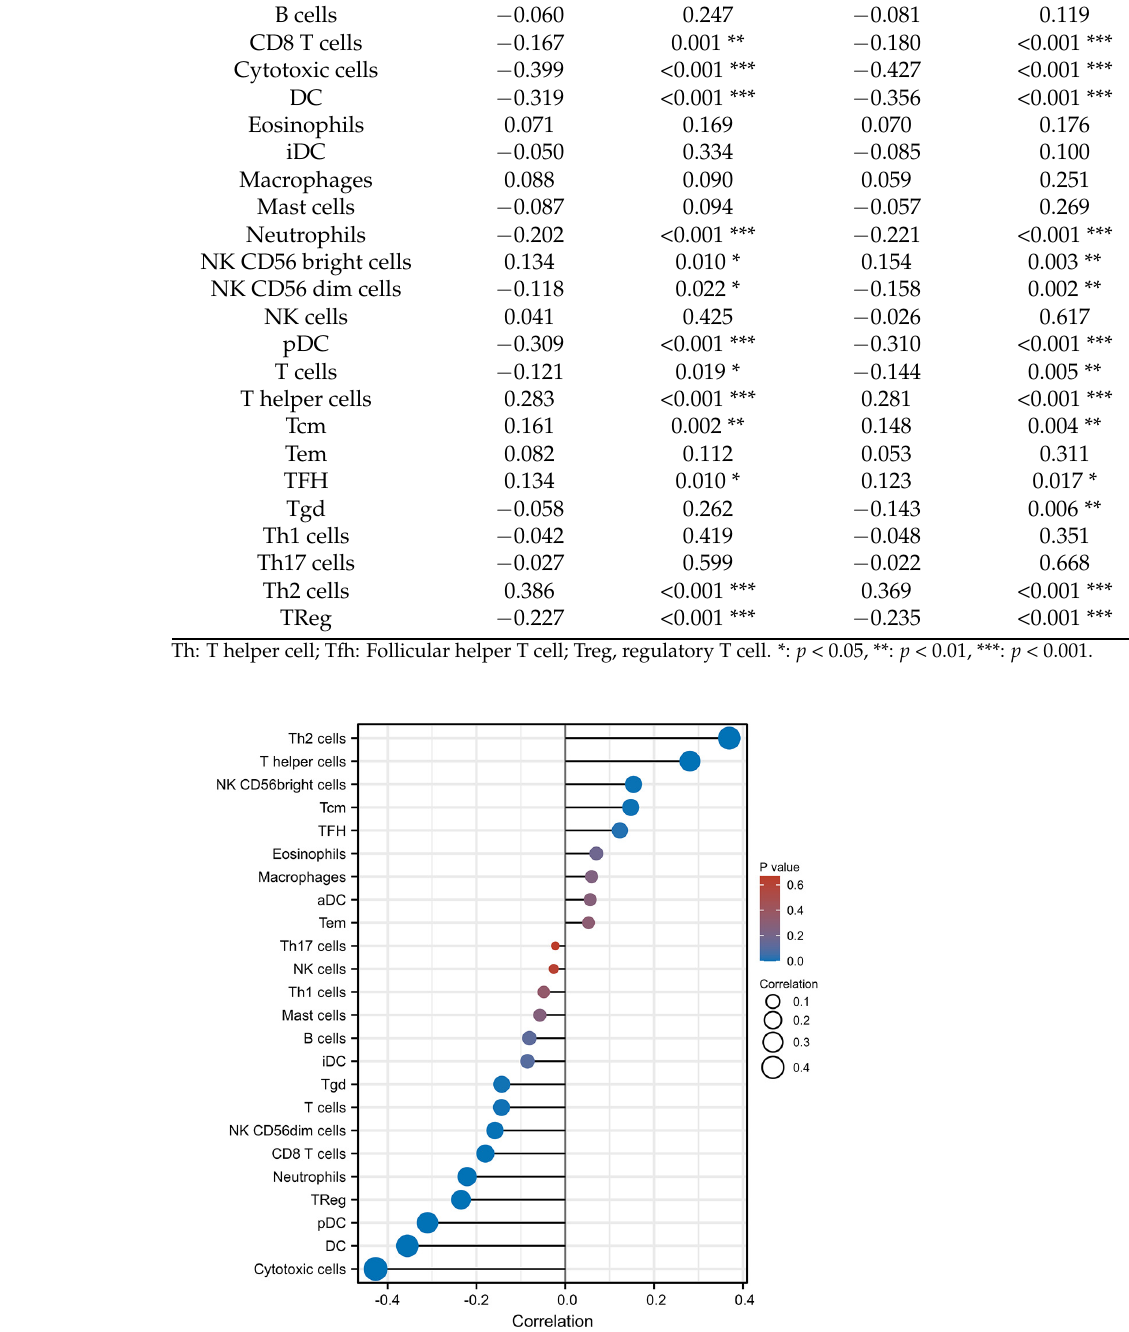
Figure 8. Correlation between POGK expression and immune cells in the tumor microenvironment. ( A ) Correlation between the relative abundances of 24 immune cells and POGK expression level. The absolute value of Spearman R was shown by the size of the dots. ( B – G ) Scatter plots and